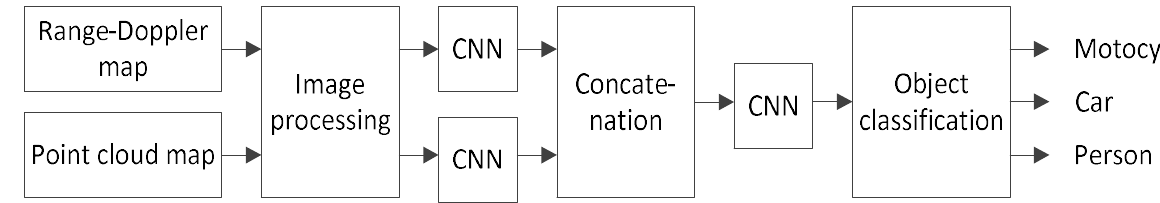
Figure 3. Block diagram of the proposed algorithm.